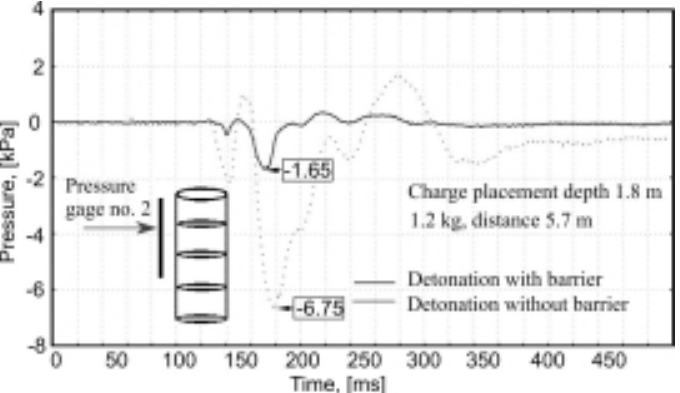
Fig. 15. Time histories of pressures p h on the structure front, measured by gage No. 2, from a detonation at 5.7 m from the silo.